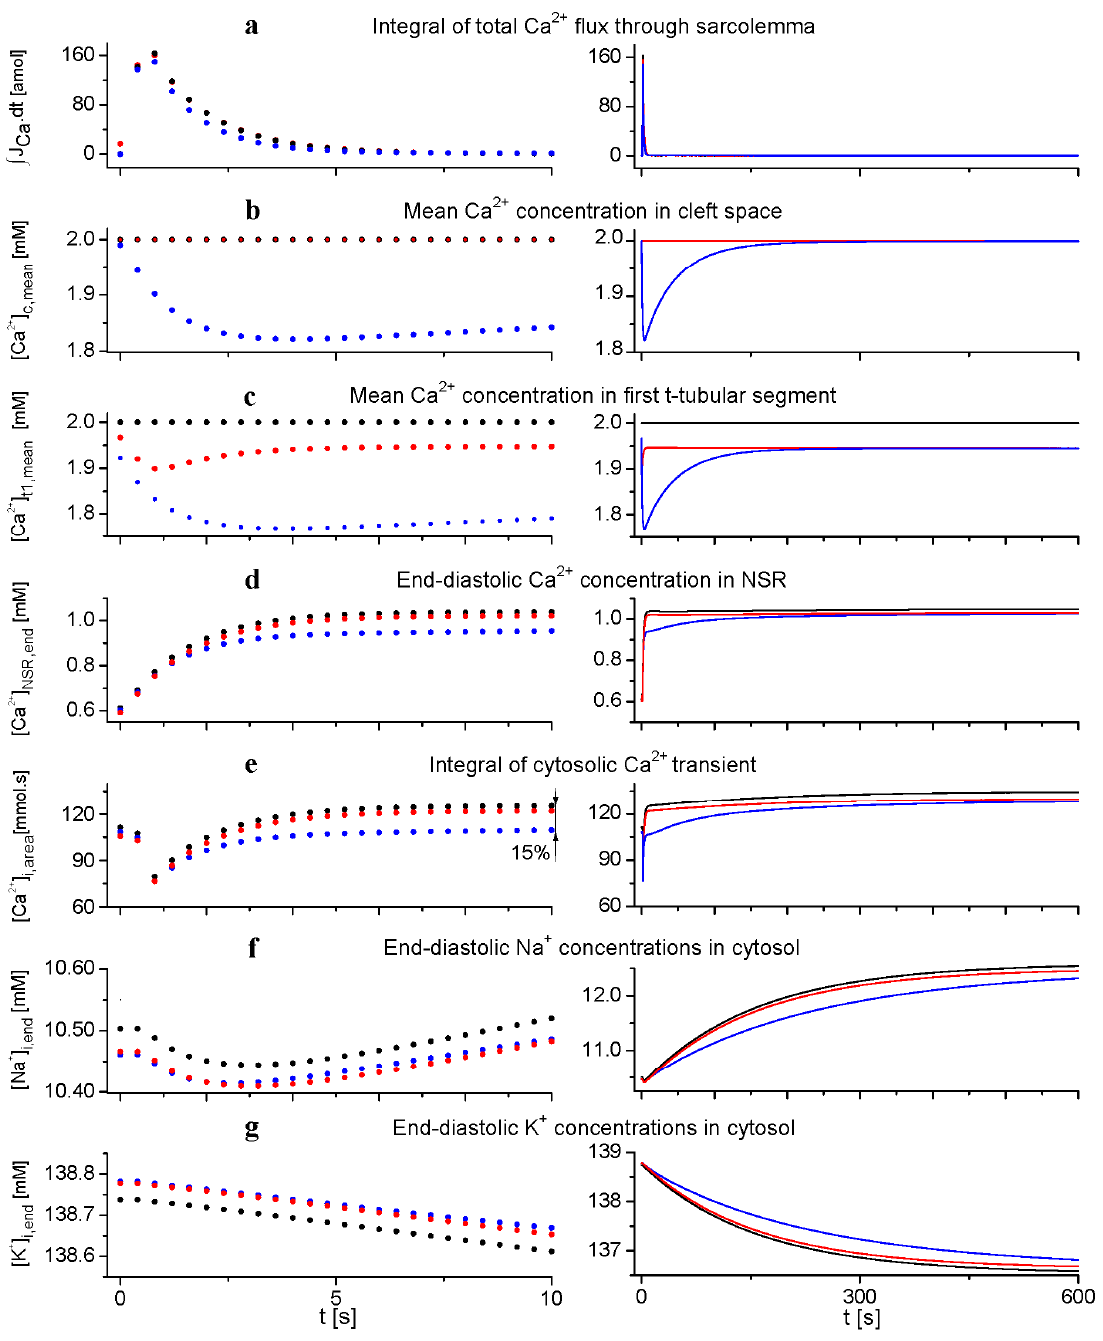
Figure 5. Effect of ion concentration changes in the cleft space ( b ) and in the first segment of t-tubular space ( c ) on intracellular end-diastolic ion concentrations ( d , f , g ) and on cytosolic Ca 2+ -transient ( e , integral of cytosolic Ca 2+ -transient during a cycle) after a sudden increase of stimulation frequency from 1 (steady state, t = 0 s) to 2.5 Hz. The upper panel ( a ) shows the integral of total trans-sarcolemmal Ca 2+ flux during a cycle. The left and right columns show the responses of the model during 10 and 600 s, respectively, after the change of stimulation rate. The model was run when t-tubular, and cleft ion concentrations were allowed to change (blue), when ion concentrations in the cleft space were fixed (red) and when both t-tubular and cleft ion concentrations were fixed at external bulk levels